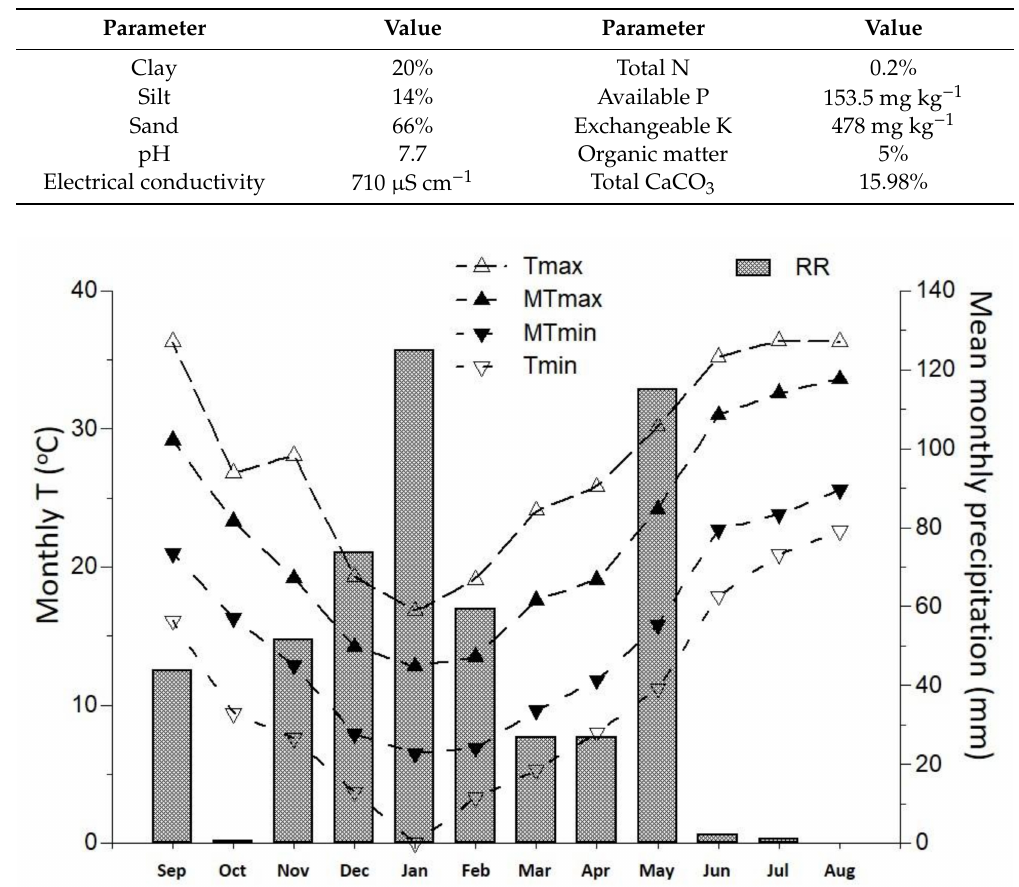
Table 1. Physical and chemical properties of the soil at the experimental field.